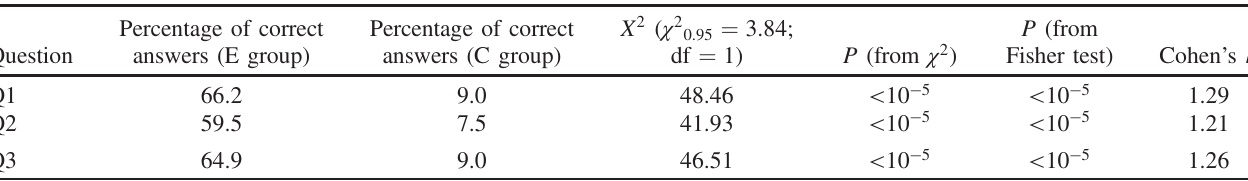
III. Percentage of correct answers to each question by the experimental groups (E group) and control groups (C group). Statistical comparison between them.